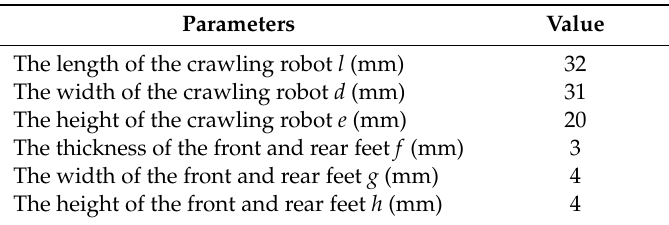
Figure 4. (a) The crawling soft robot is composed of the two independent PFAs, the left PFA and right PFA. (b) The sealing part is designed as feet from the left view. Table 2. The Parameters of the Crawling robot. Table 2. The Parameters of the Crawling